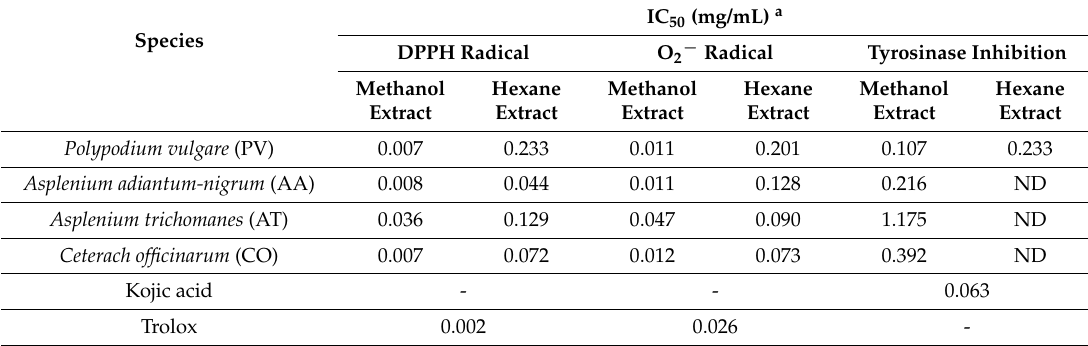
Figure 3. Antioxidant activity of fern methanolic ( A ) and hexane ( B ) extracts against superoxide radicals generated by xanthine/xanthine oxidase using trolox as a reference. *** p < 0.001 versus the hexane extract in the same species. Table 3. Summary of IC 50 values of methanolic and hexane extracts in the DPPH, xanthine/xanthine oxidase, and tyrosinase